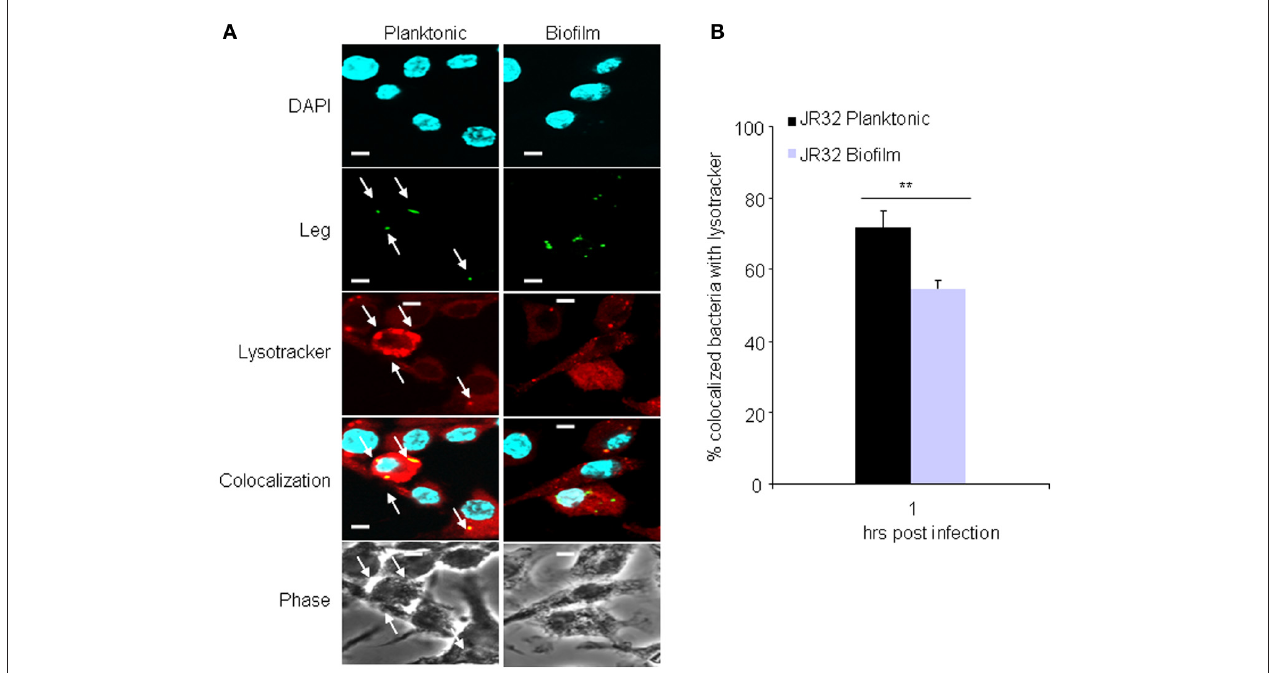
FIGURE 4 | Vacuolesharboring biofilm-derived L. pneumophila bacteria significantlyevadefusion with lysosomes.(A) Representativeimagesof WT BMDMsinfectedfor 1h with JR32 planktonicor biofilm. Nucleiare stained bluewithDAPIand L.pneumophila stainedgreenwith L.pneumophila -specific antibody.Lyso-tracker redwas usedto stain acidifiedlysosomes.White arrows